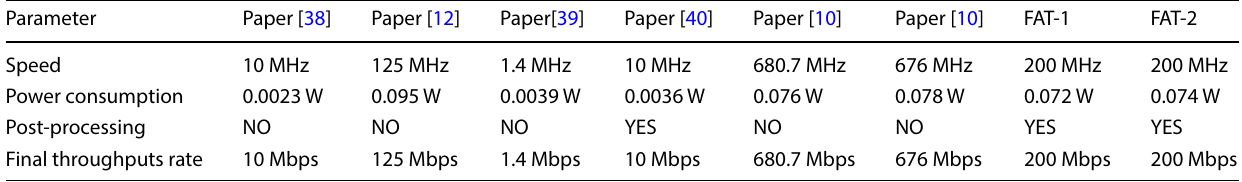
Table 9 Synthesis results comparison among different TRNG architecture